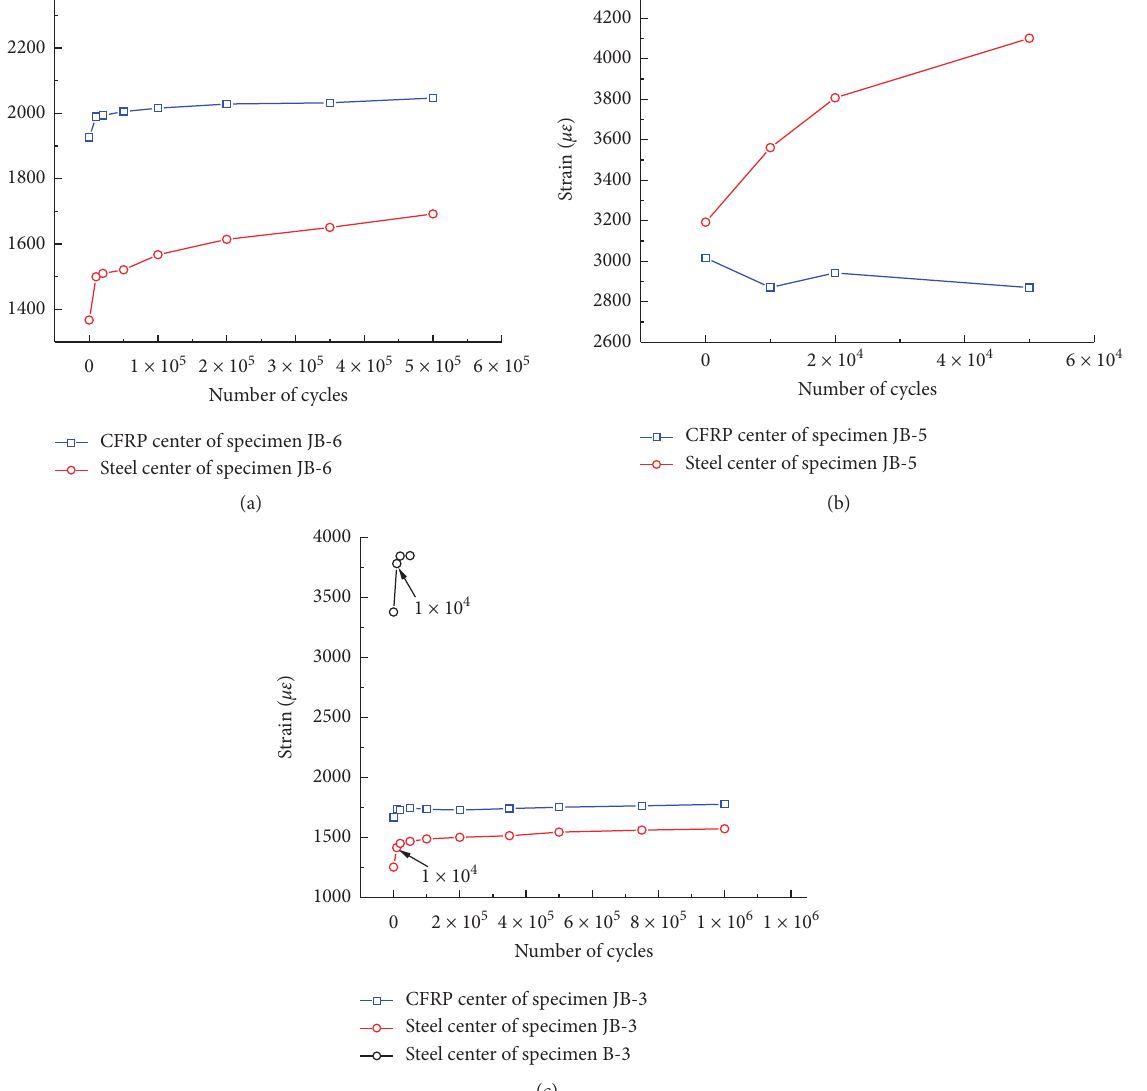
� 30kN. (b) P � 39kN. (c) P � 27 max max max